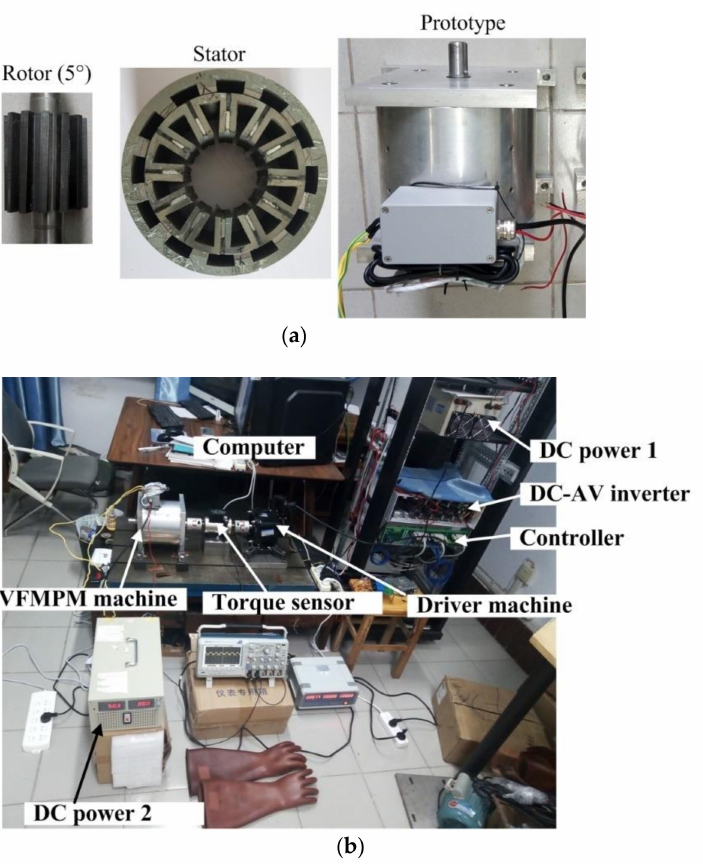
Figure 7. The prototype of the VFMPM machine and test rig. ( a ) VFMPM machine; ( b ) Test